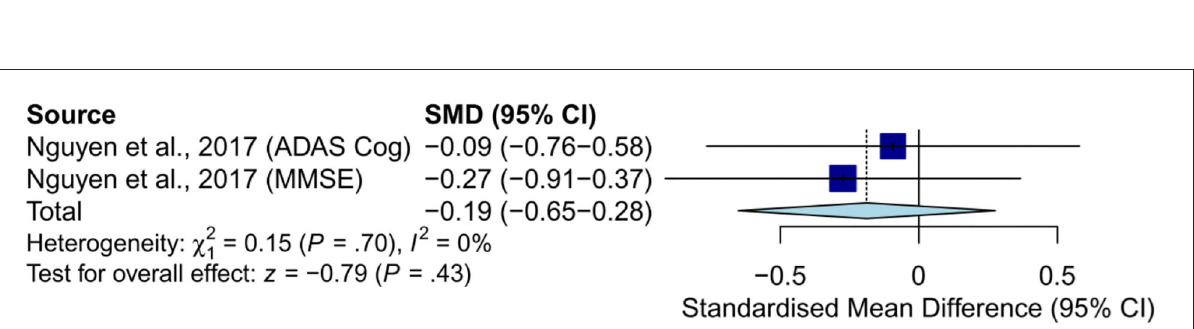
FIGURE3 Meta-analysis of SMD (common-effect model) in the effects of hearing aids on global cognition in subjects with AD. ADAS-Cog, Alzheimer’s Disease Assessment Scale-Cognitive subscale; MMSE, Mini-Mental State Examination.